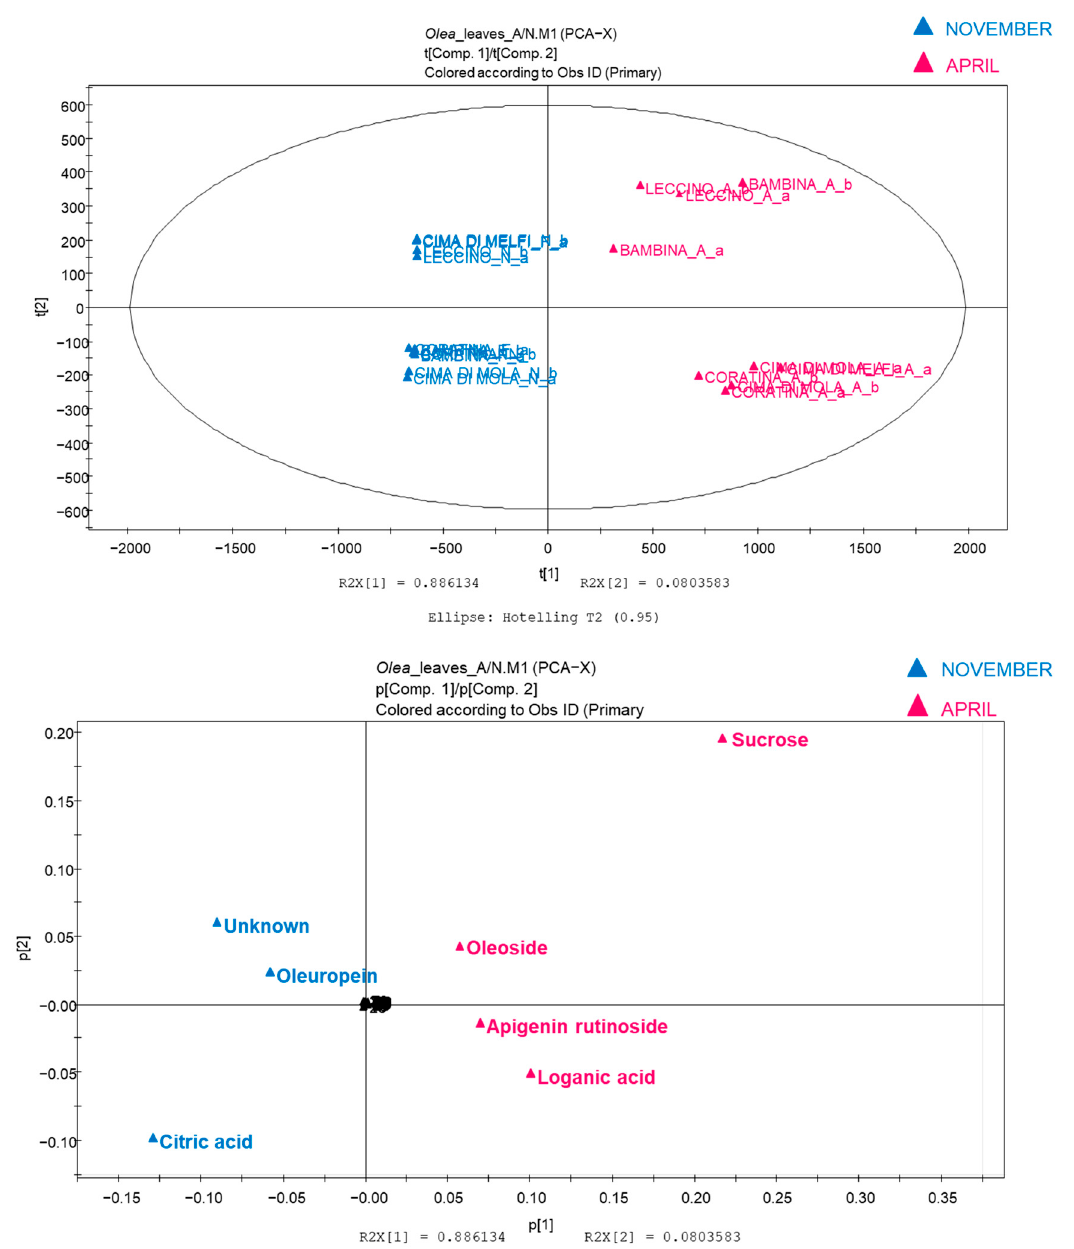
Figure 3. Principal component analysis (PCA) of hydro-alcoholic extracts of olive leaves (pseudo- targeted approach). Score scatter plot and loading scatter plot are reported: A, April; N, November.